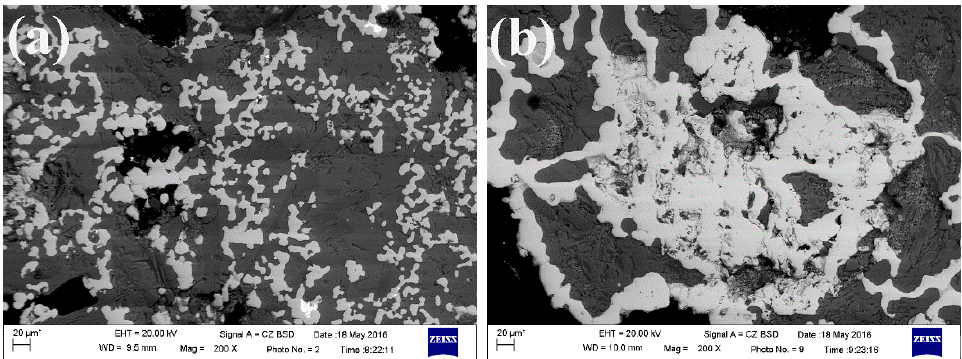
Figure 8. SEM images of roasted products obtained at 1050°C (a) and 1200°C (b) with same magnification of 200.